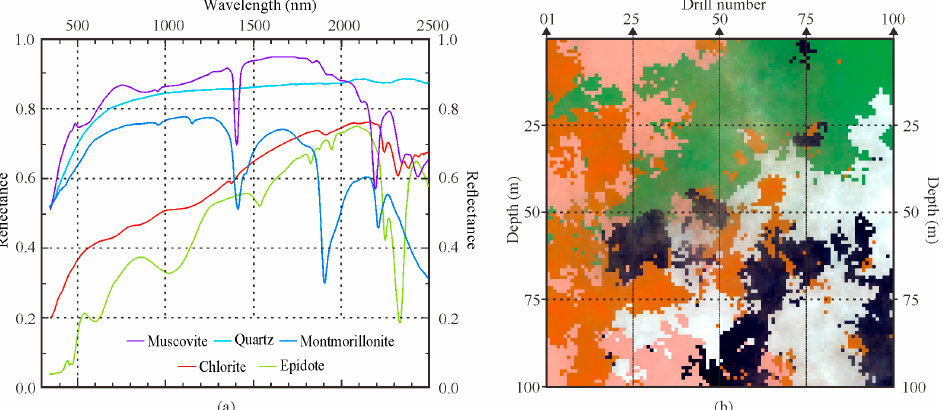
Figure 5. ( a ) The spectra selected from USGS; ( b ) Synthetic dataset with fake color (1040 nm, 2340 nm, and 1415 nm). Where row and column present the drill core number and the depth, respectively.